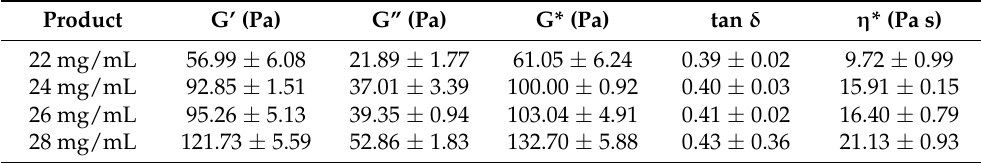
Table 3. Rheological data of four HA hydrogel dermal fillers, provided by Matex Lab S.p.A., character- ized with respect to their Linear Viscoelastic Region (LVER) at temperature of 37 ◦ C and at a shear strain value of 1%. Data are presented as averages and relative standard deviation percentage (RSD %).